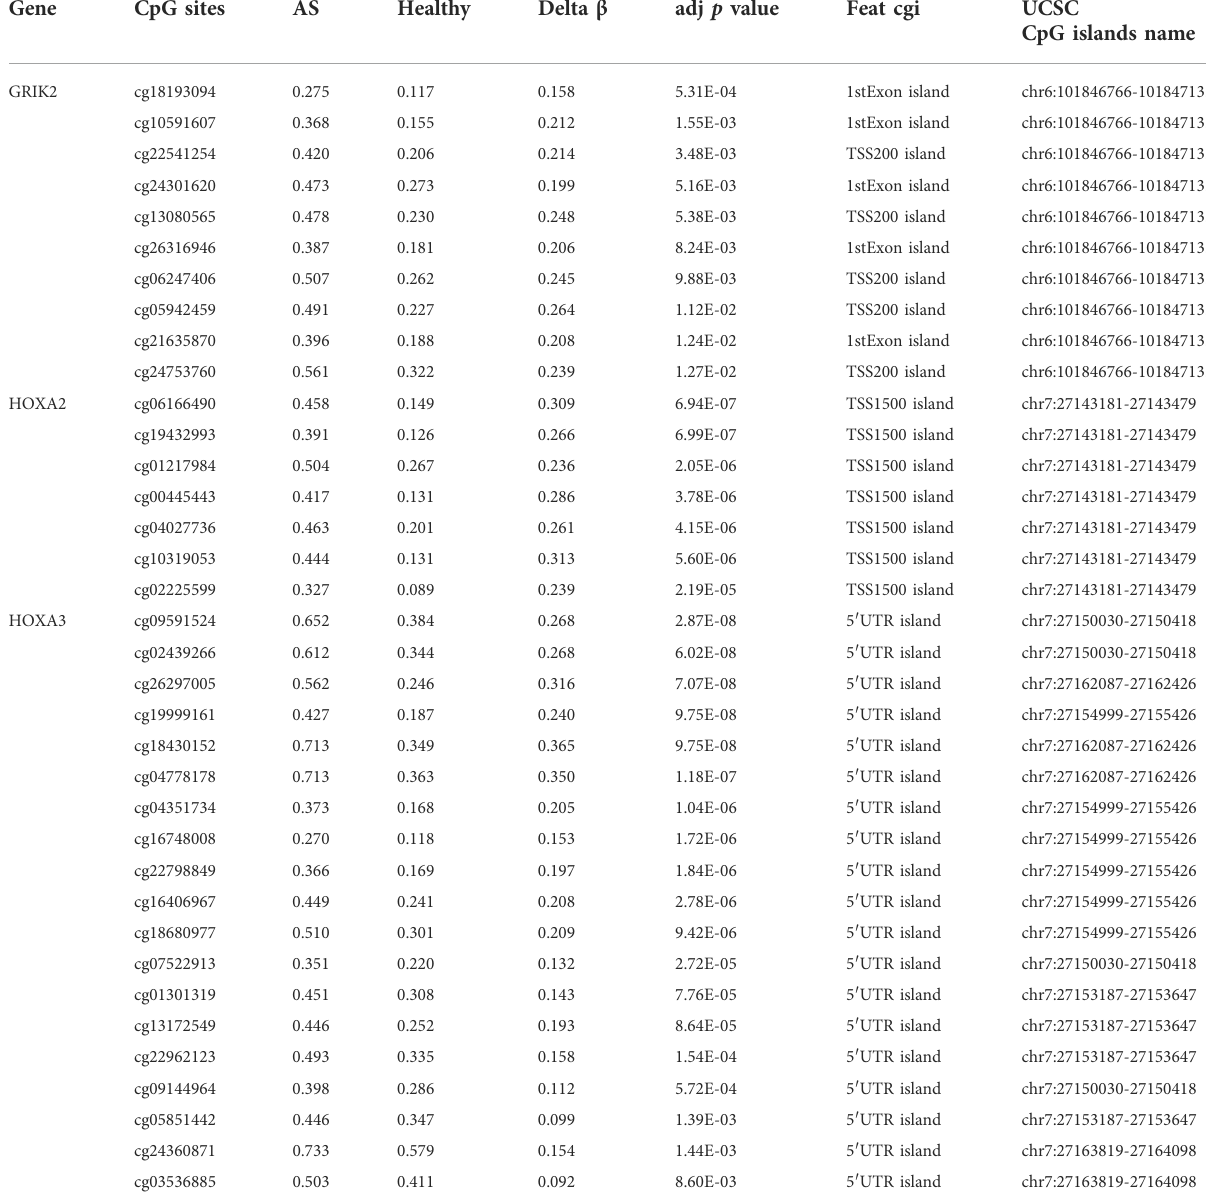
TABLE 3 Characteristics of CpG sites located on the islands of gene promoter regions. Gene CpG sites